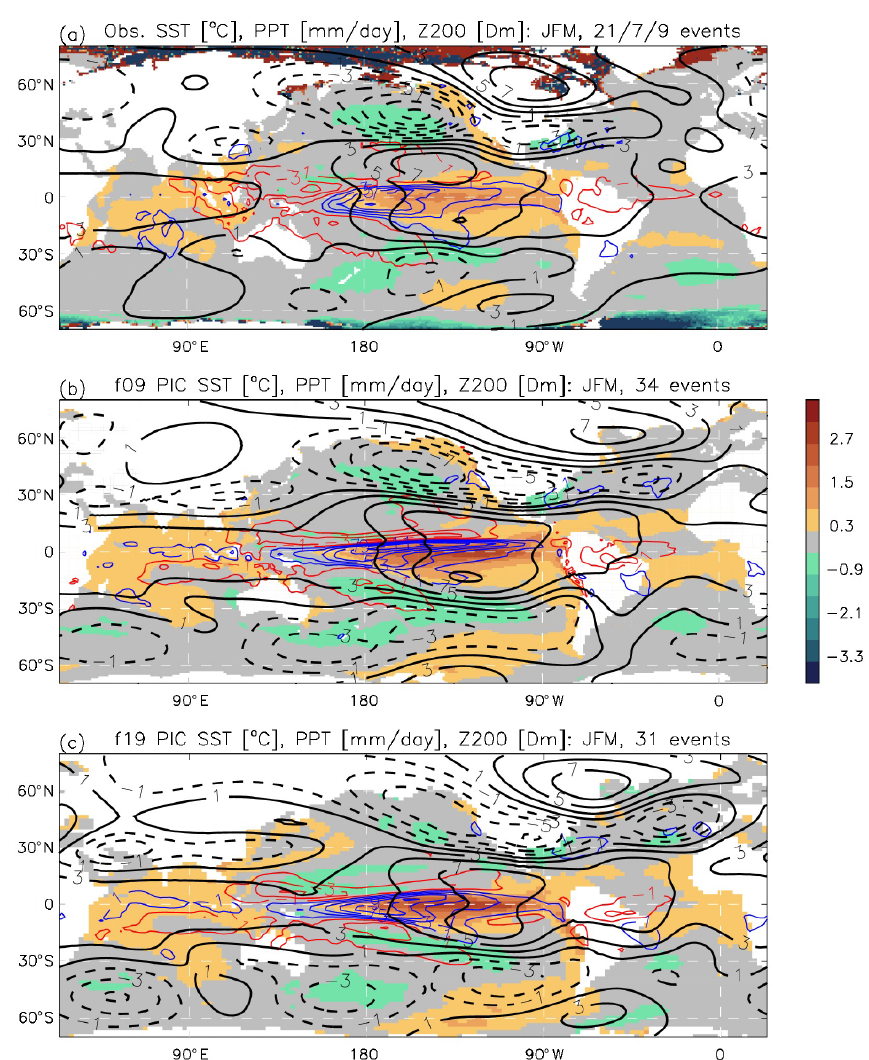
Figure 23. El Niño JFM composite anomalies from observations (a) , NorESM2-MM (b) , and NorESM2-LM (c) . Colour-filled contour levels denote SST anomalies (contour levels indicated in the legend on the right side of panel b ), precipitation anomalies (coloured line contours, red for negative values and blue for positive values; interval 2mmd − 1 ), and geopotential height anomalies at 200hPa (black and white contour lines, solid for positive and stippled for negative values; interval 20m). The composites are defined as for Fig. 22 (see the caption to that